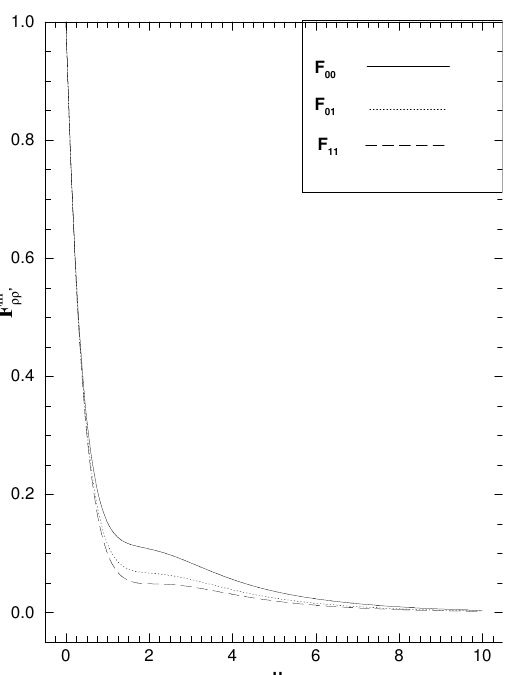
Figure 8. Spin structure function in the inelastic channel 3/2 +